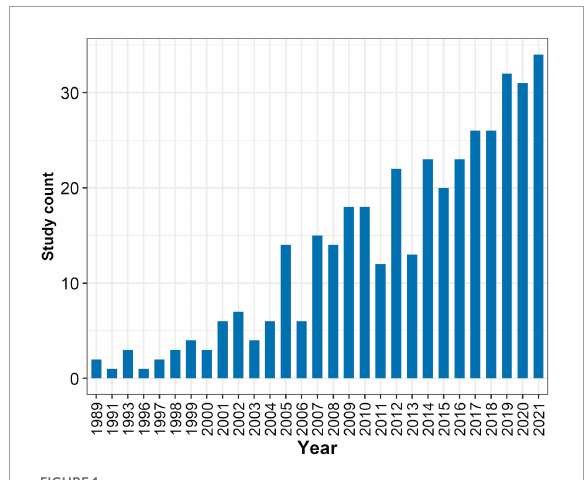
FIGURE1 Ecological studies addressing dung beetles throughout the years. Data gathered from a search on Web of Science using the following terms: ((“Dung Beetle*” OR Scarabaeinae) AND